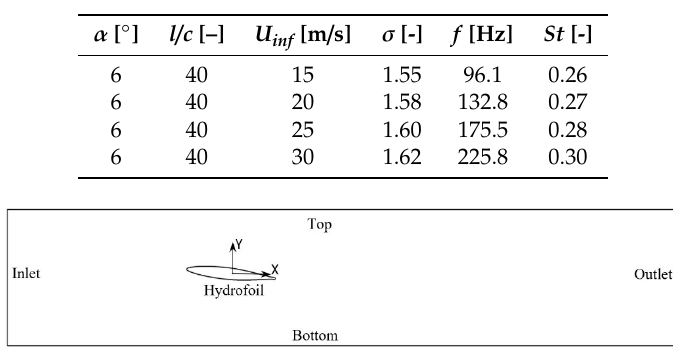
Table 1. Flow conditions and results for the validation experiment [29].